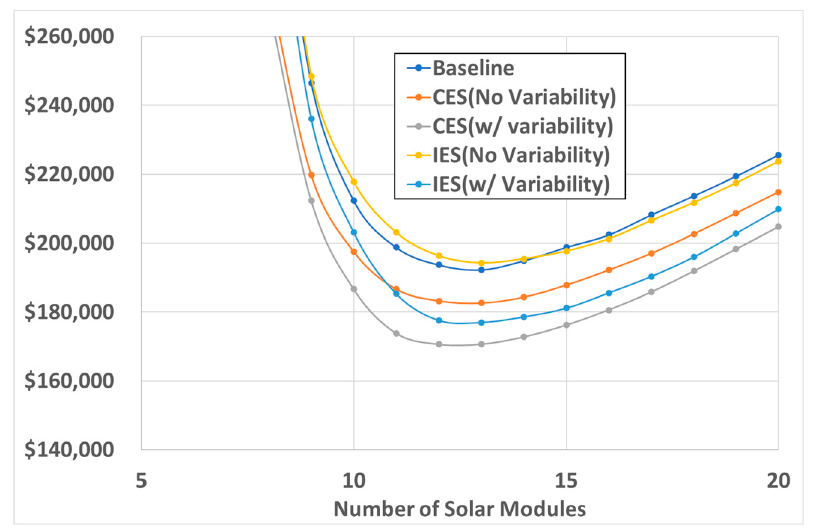
Figure 9. Changing load offset method given June, 10% initial charge, five systems, San Antonio, and 0.1% LPSP.